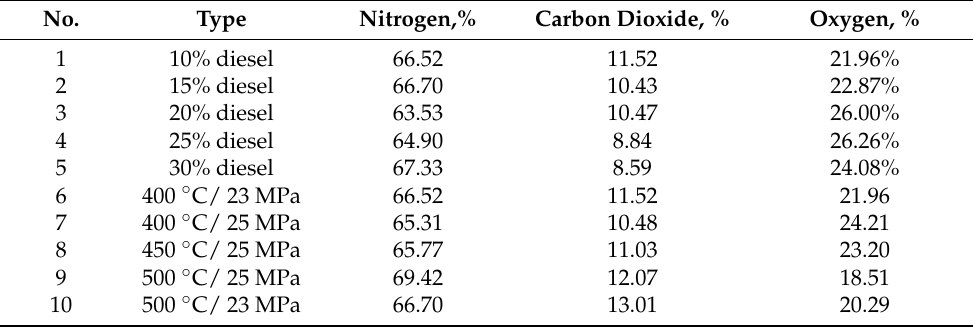
Table 7. Gas chromatographic analysis results after supercritical water–diesel reaction.